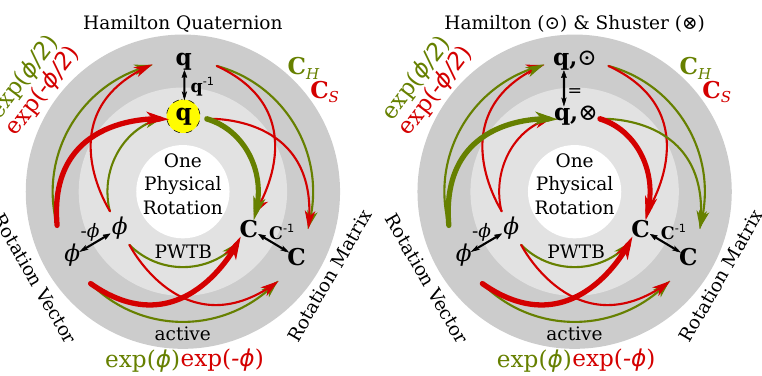
Figure 1. Active (or passive body-to-world; outer ring) and passive world-to-body (=:PWTB; inner ring) representations of a single physical rotation with the three common parametrizations: rotation matrix, C , rotation vector φ , and rotation quaternion q . Their mutual conversions are represented by arrows pointing to the codomain of the associated expression/function name (nearby and the same color). On the left, Hamilton multiplication only : Black arrows represent conversion between active and PWTB usage while keeping the parametrization, green arrows represent conversion between different parametrizations while keeping the usage, and red arrows represent additional switching of the usage. The bold arrows constitute the homomorphic convention suggested in this paper. It is suitable for everybody preferring PWTB for q and C . The rare users of PWTB rotation vectors would instead entirely remain in the inner circle. Clinging to the green conversion from the common active φ to q even if q is intended to be employed PWTB, as done in [1] leads to the situation on the right, using Shuster’s multiplication for quaternions used passively . The colors are kept for conversion functions that also appear on the left (all except the identity conversion between Hamilton and Shuster quaternions). This conventional branch neglects the option of the highlighted inverted q (on the left) and thus requires the flipped multiplication, ⊗ , and inevitably breaks the symmetry between C and q on the right compared to the left, i.e., there is no coloring of conversion functions that achieves the same level of